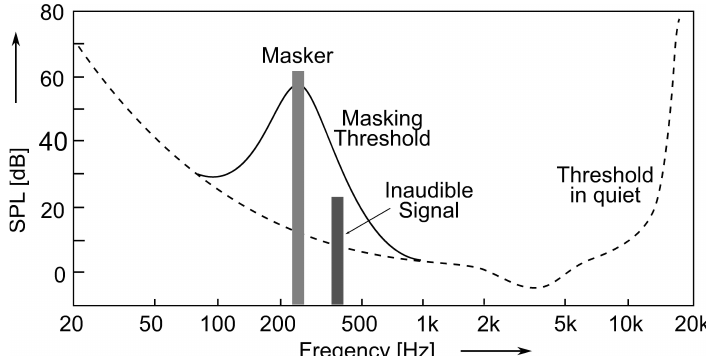
Figure 3. Illustration of spectral masking e ff ects. Dashed line represents threshold of hearing in quiet, solid line illustrates the masking threshold due to the presence of a masker signal (e.g., narrow-band noise), due to which weaker signals at neighboring frequencies become